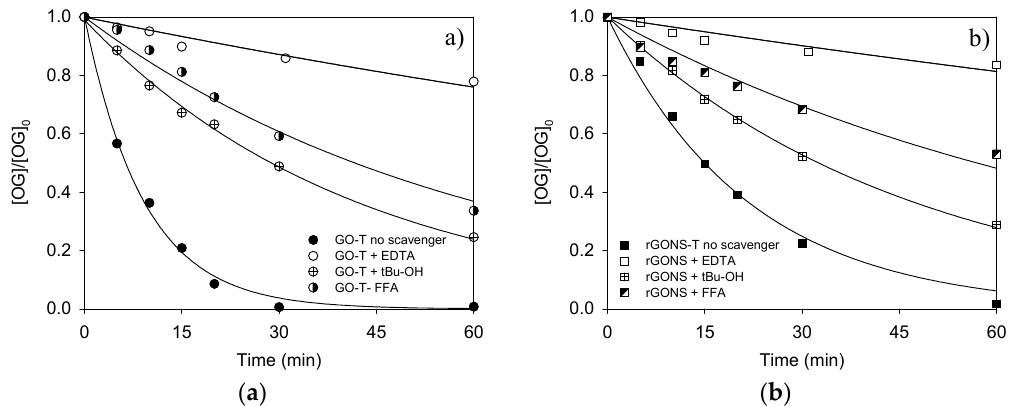
Figure 7. Normalized concentration of OG as a function of time with and without scavengers for ( a ) GO-T and ( b ) rGONS-T.